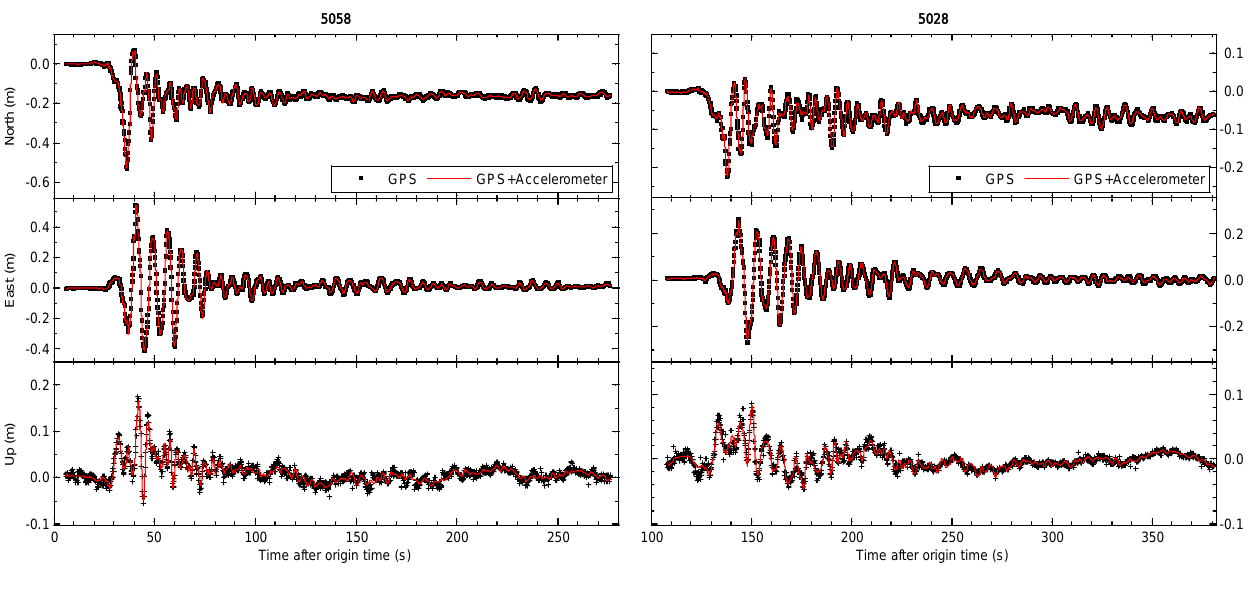
Figure 3. Comparison of GPS-only and tightly-integrated displacements on the collocated 5058 (seismic) and P496 (GPS) pair and 5028 (seismic) and P744 (GPS) pair during the El Mayor–Cucapah earthquake on 4 April 2010. The sub-figures from top to bottom show the entire period of seismic shaking in north, east and up components respectively. The 5 Hz GPS-only and 200 Hz tightly-integrated displacements are shown respectively by the black cross symbols and red lines.